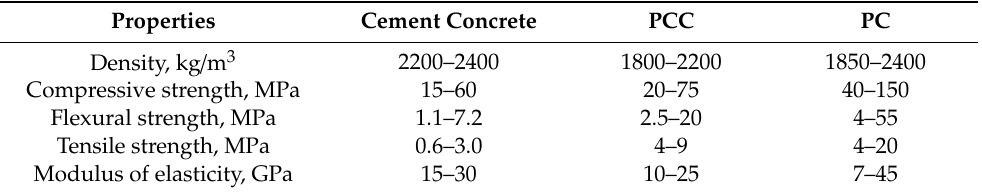
Table 1. Comparison of selected properties of polymer-cement concretes (PCC), polymer concretes (PC), and Portland cement concretes